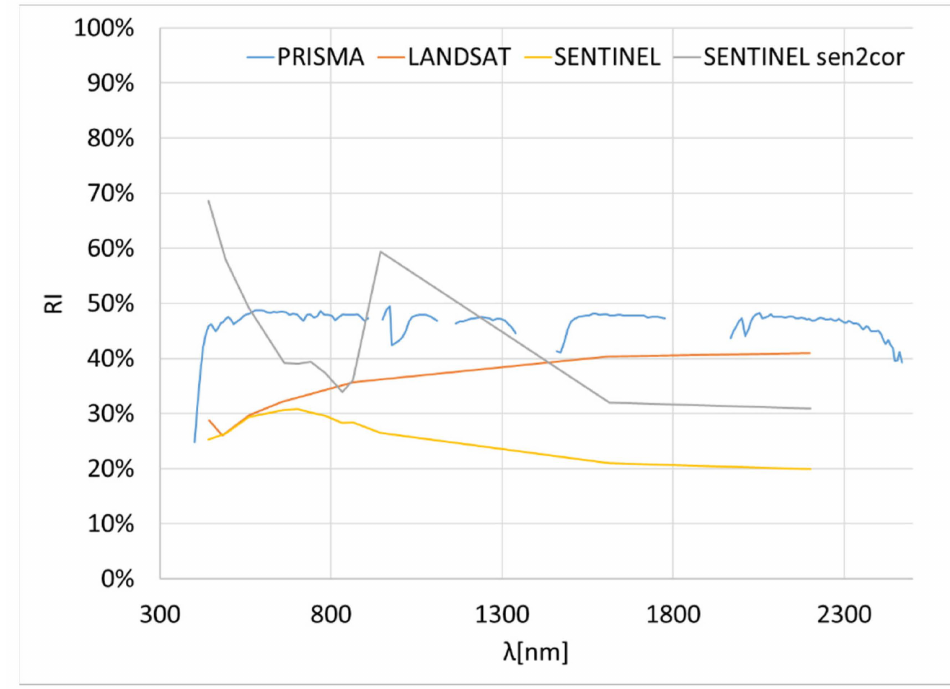
Figure 6. RI plots as a function of wavelength for PRISMA, Landsat 8 and Sentinel 2 sensors. For Sentinel 2 both ImaACor and sen2cor RI are shown.